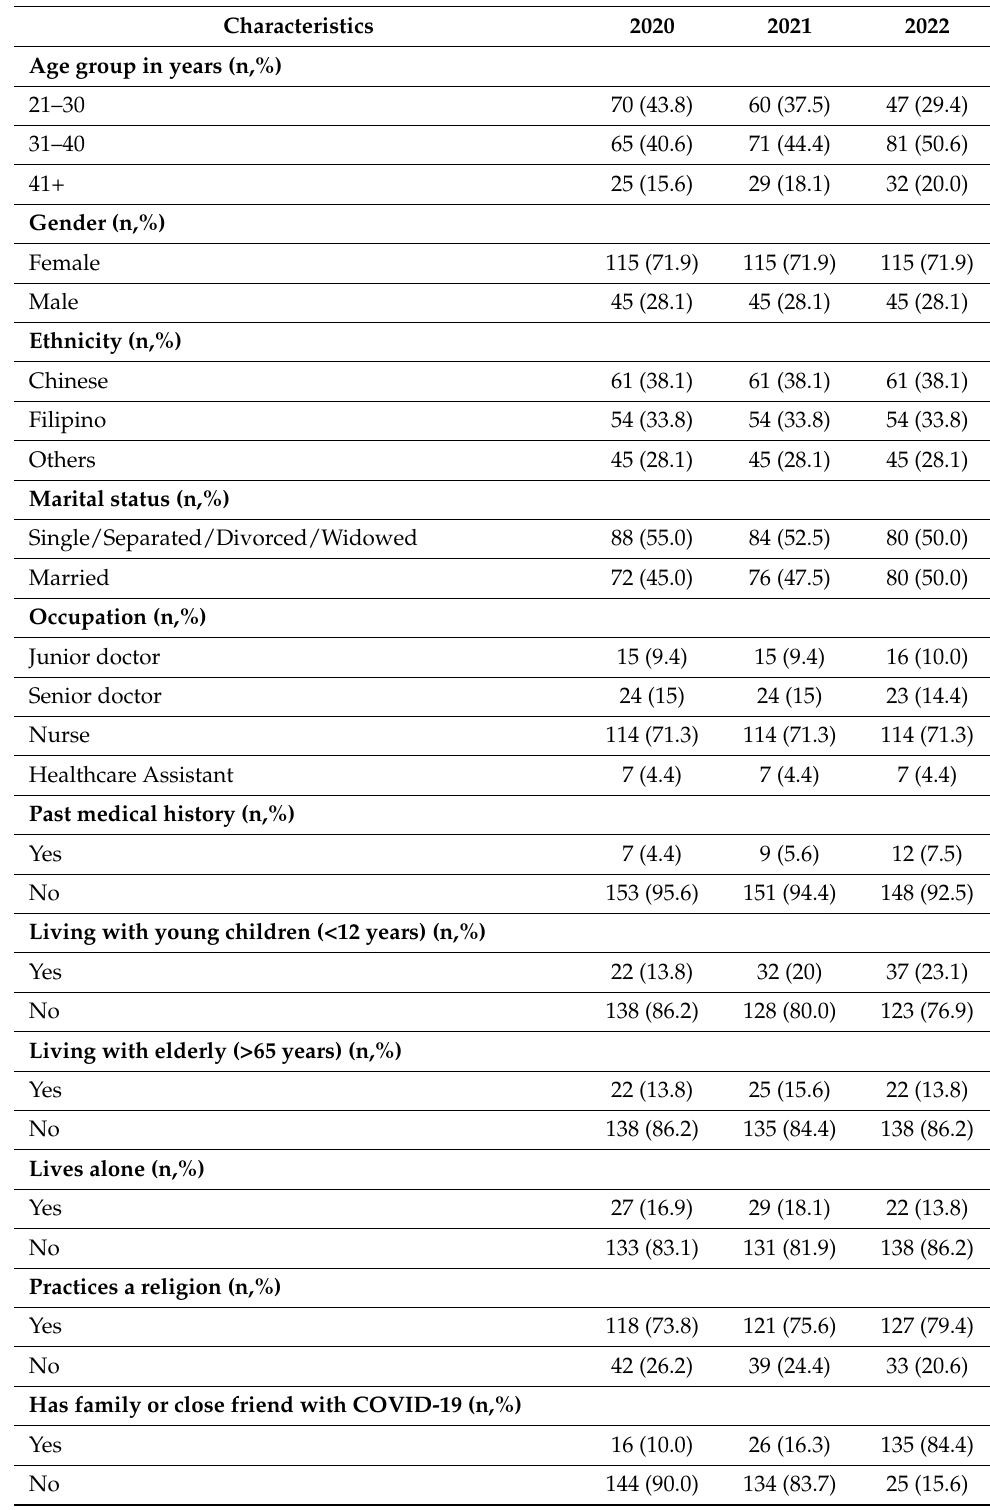
Table A3. Demographic characteristics of 160 ED HCWs who participated in all 3 surveys. There were 39 doctors (24%) and 121 nursing staff